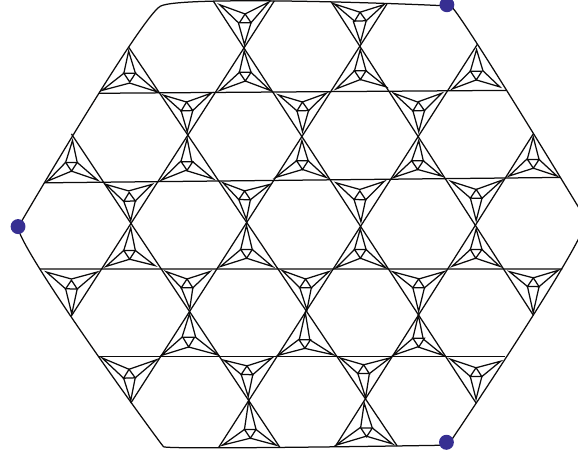
Figure 3: Hexagonal planar octahedral network HPOH ( 2 )